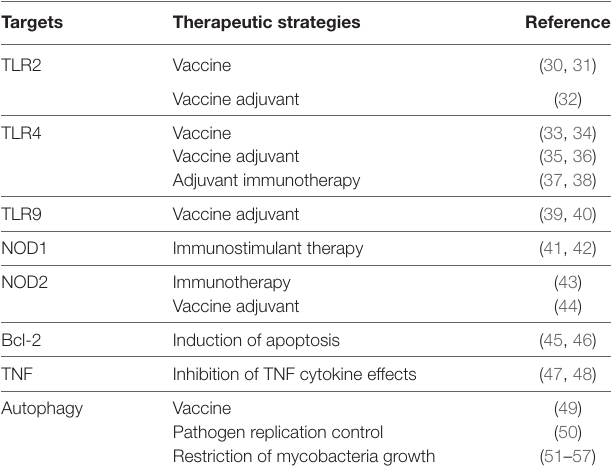
TAbLe 1 | Innate immunity-modulating strategies and possible therapeutic